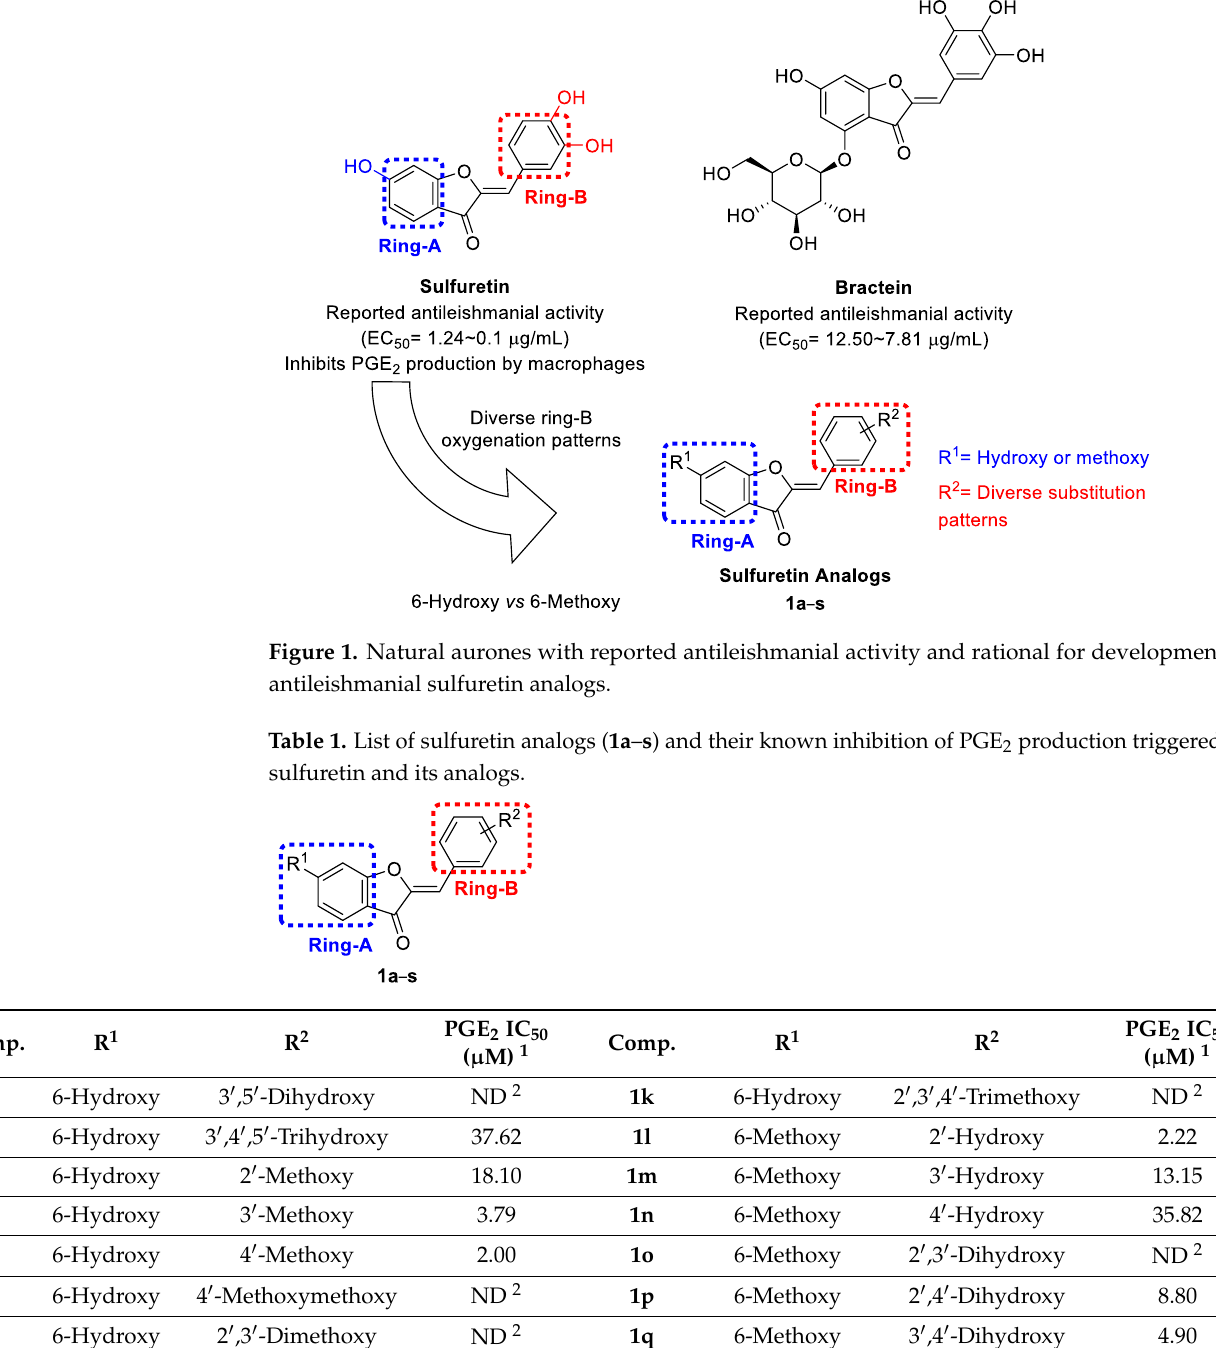
Figure 1. Natural aurones with reported antileishmanial activity and rational for development of antileishmanial sulfuretin analogs.